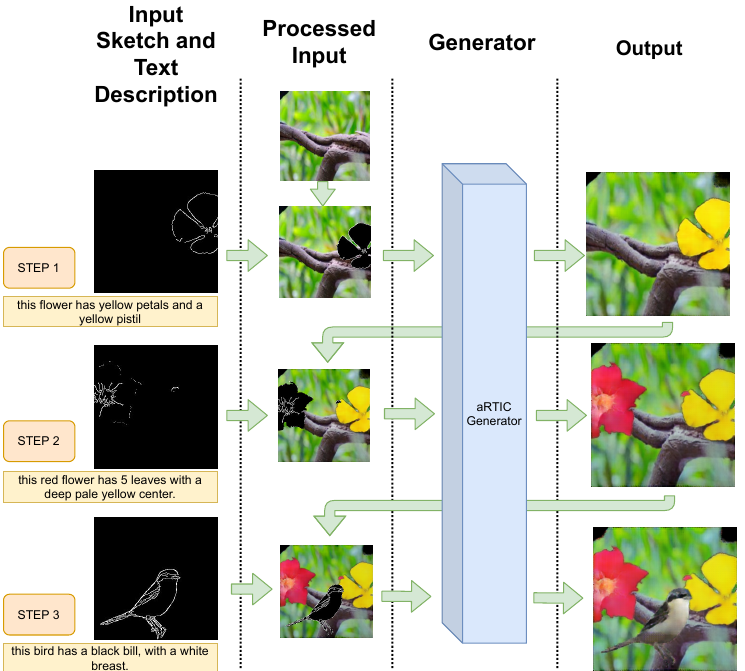
Figure 1. Theproposed generation process of aRTIC GAN. The model is recursively fed with sketches composed of a few lines, short yet informative descriptions and either a background or the previous generated image.